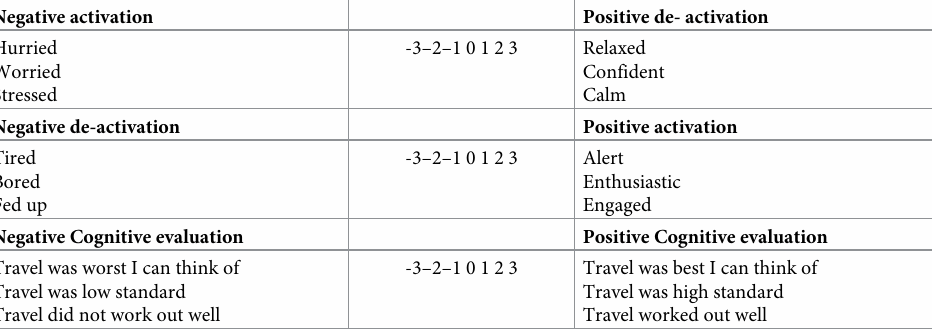
Table 4. Statements included in the satisfaction with travel scale